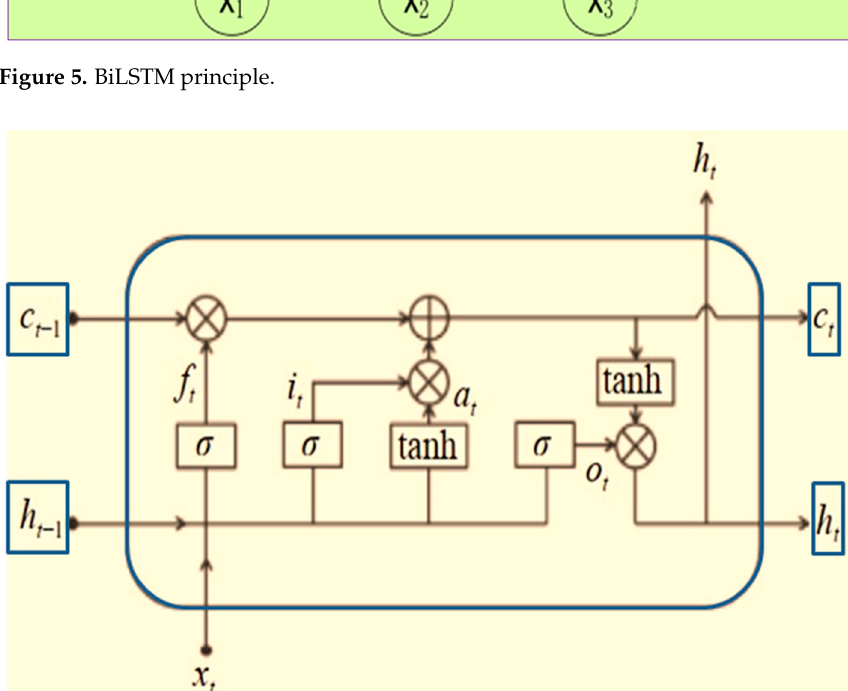
Figure 6. LSTM principle. Figure 6. LSTM